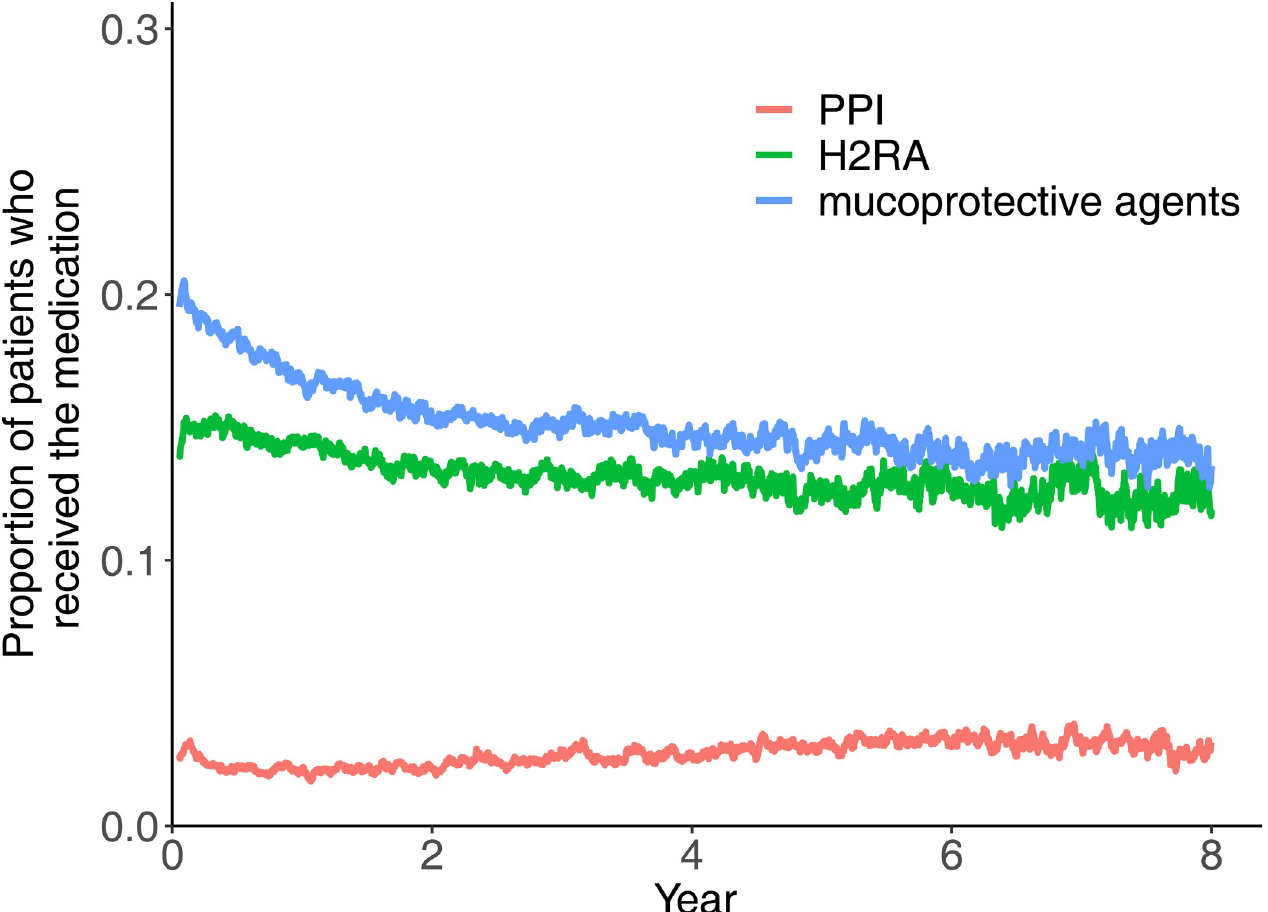
Fig 2. Proportion of patients who received medications thoughout the post-stroke period. Mucoprotective agents include rebamipide, teprenone, irsogladine, ecabet, polaprezinc, sofalcone, sucralfate, and misoprostol. Abbreviations: H 2 RA, H 2 -receptor antagonist; PPI, proton-pump inhibitor.